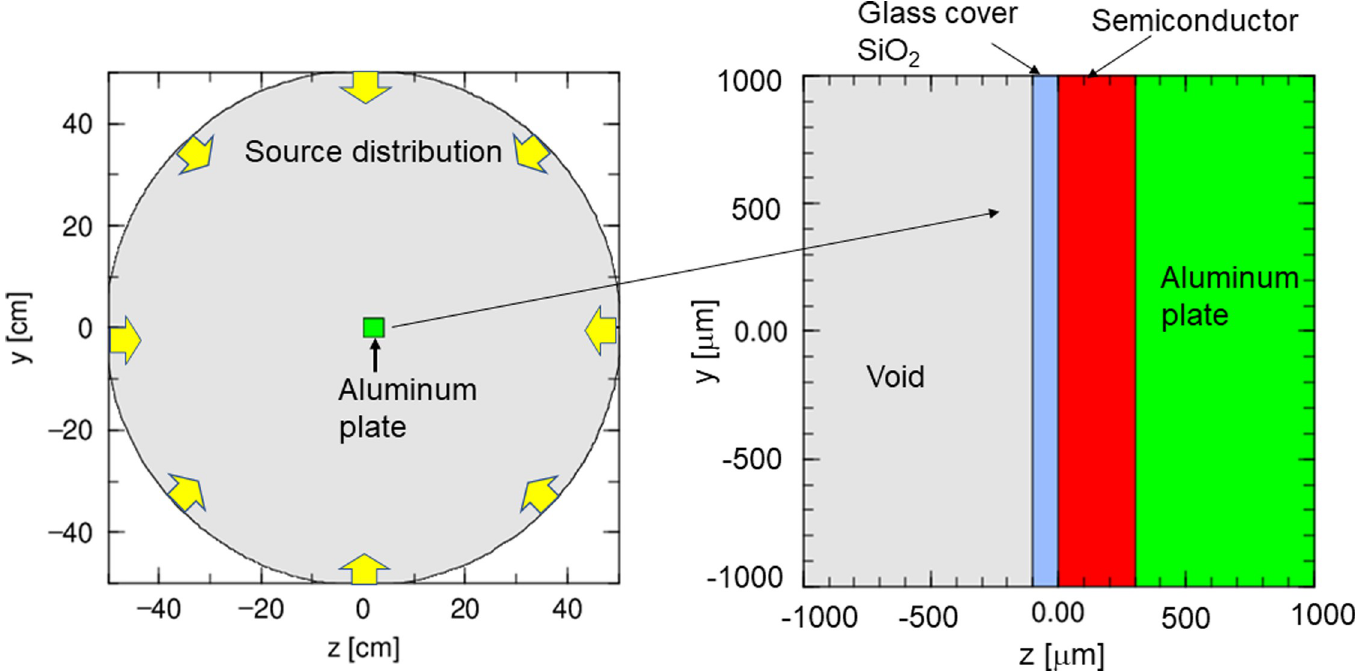
Fig 4. Calculated DDD geometry for a semiconductor exposed to cosmic rays as determined in the PHITS code. In this diagram, space-based radiation is emitted from the surface of the sphere towards the center. The device comprises a glass cover made of SiO 2 , a semiconductor and an aluminum plate. The thickness of the glass cover was varied from 0 to 800 μ